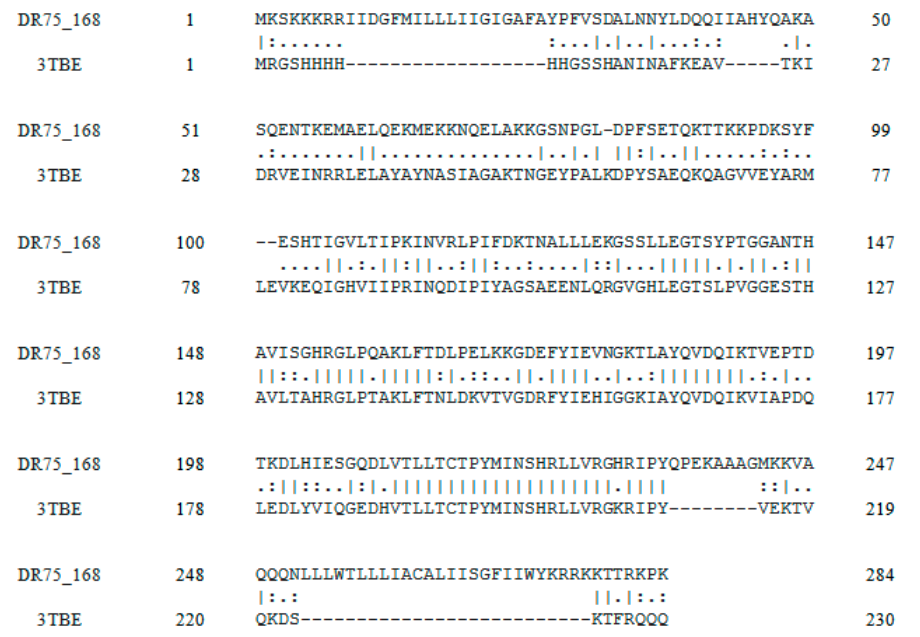
Figure 3. Sequence alignment between E. faecalis Sortase A (DR75_168) and the template structure (3TBE). Root mean square deviation (RMSD) between the template and newly generated Sortase A structure (further referred to as EfSRT_29212) structures was found to be equal to 0.129 Ǻ . z -Score computed for the template was found to be equal to − 4.96 kcal/mol while the one for the EfSRT_29212 structure was found to be equal to − 5.8 kcal/mol, as shown in Figure 4.